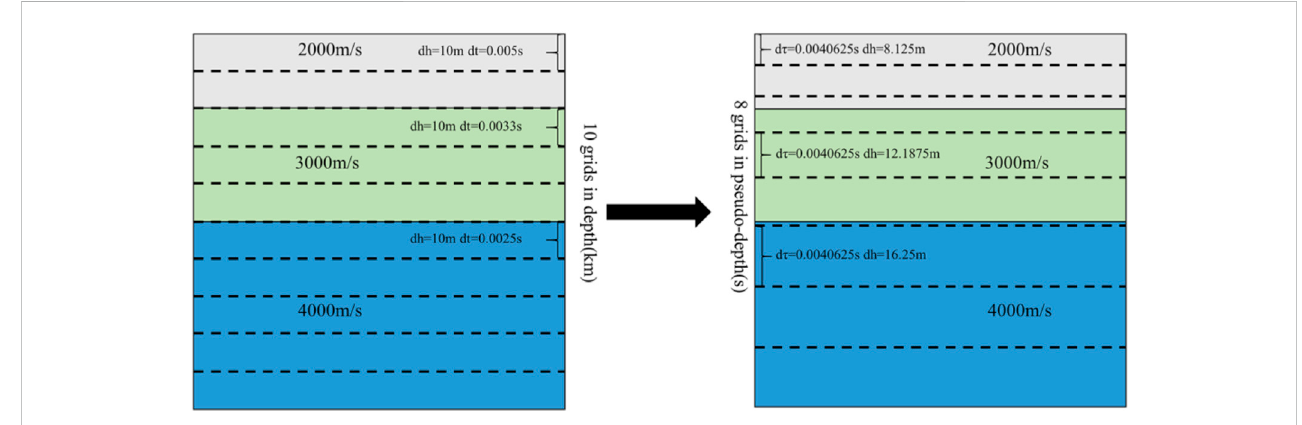
FIGURE 1 Schematic diagram of pseudo-depth domain transformation principle in depth